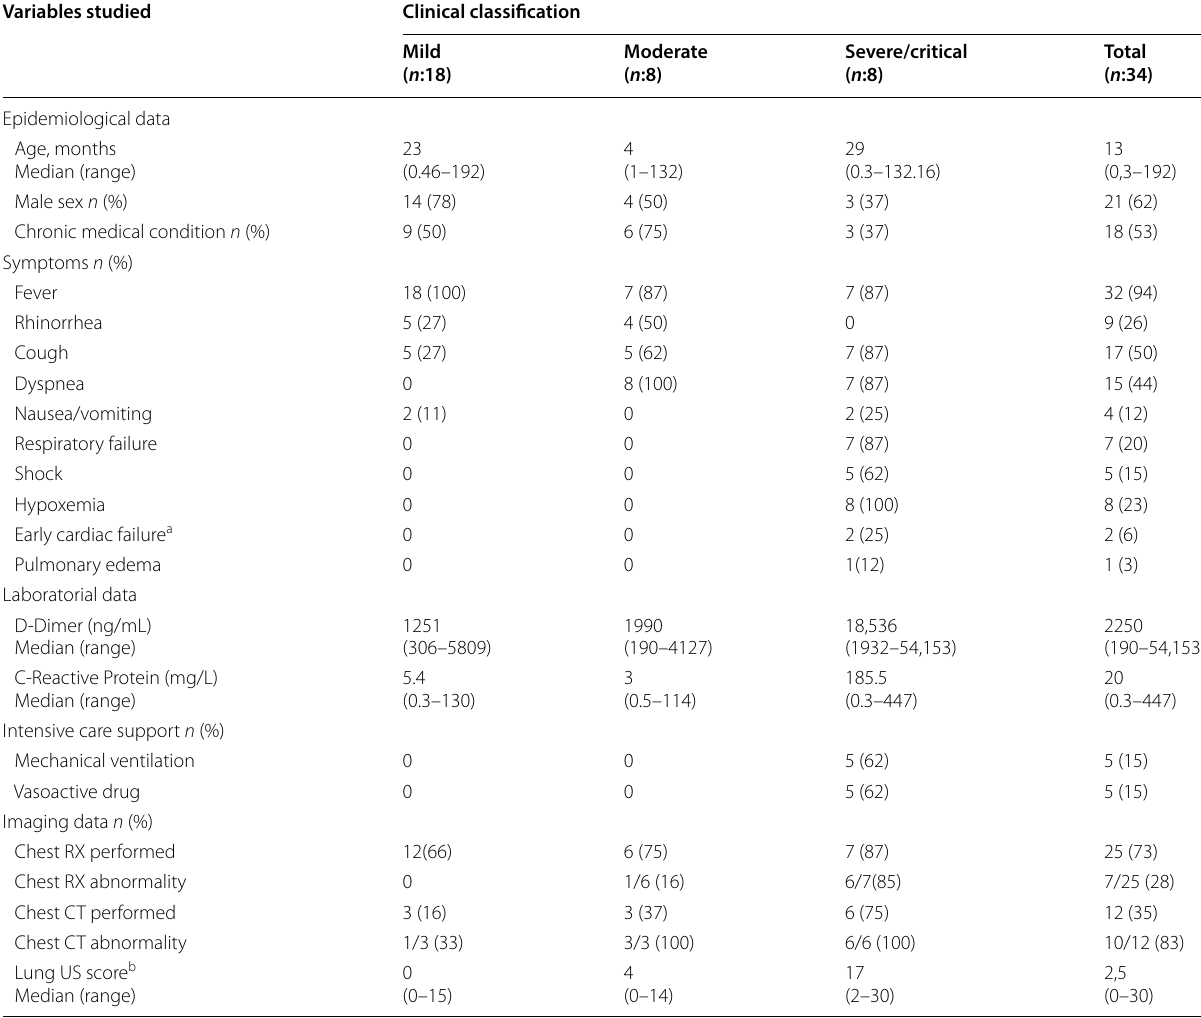
Table 1 Summary of the clinical features of the